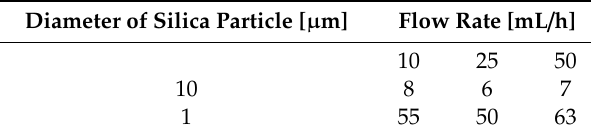
Figure 4. Time dependence of the concentration of silica particles eluted from the Mag gel-packed column. Circles: 1 µ m, triangles: 10 µ m. The injected volume of silica suspension was 0.4 mL, and the suspension concentration was 1.0 g / L. Table 1. Percentage of silica